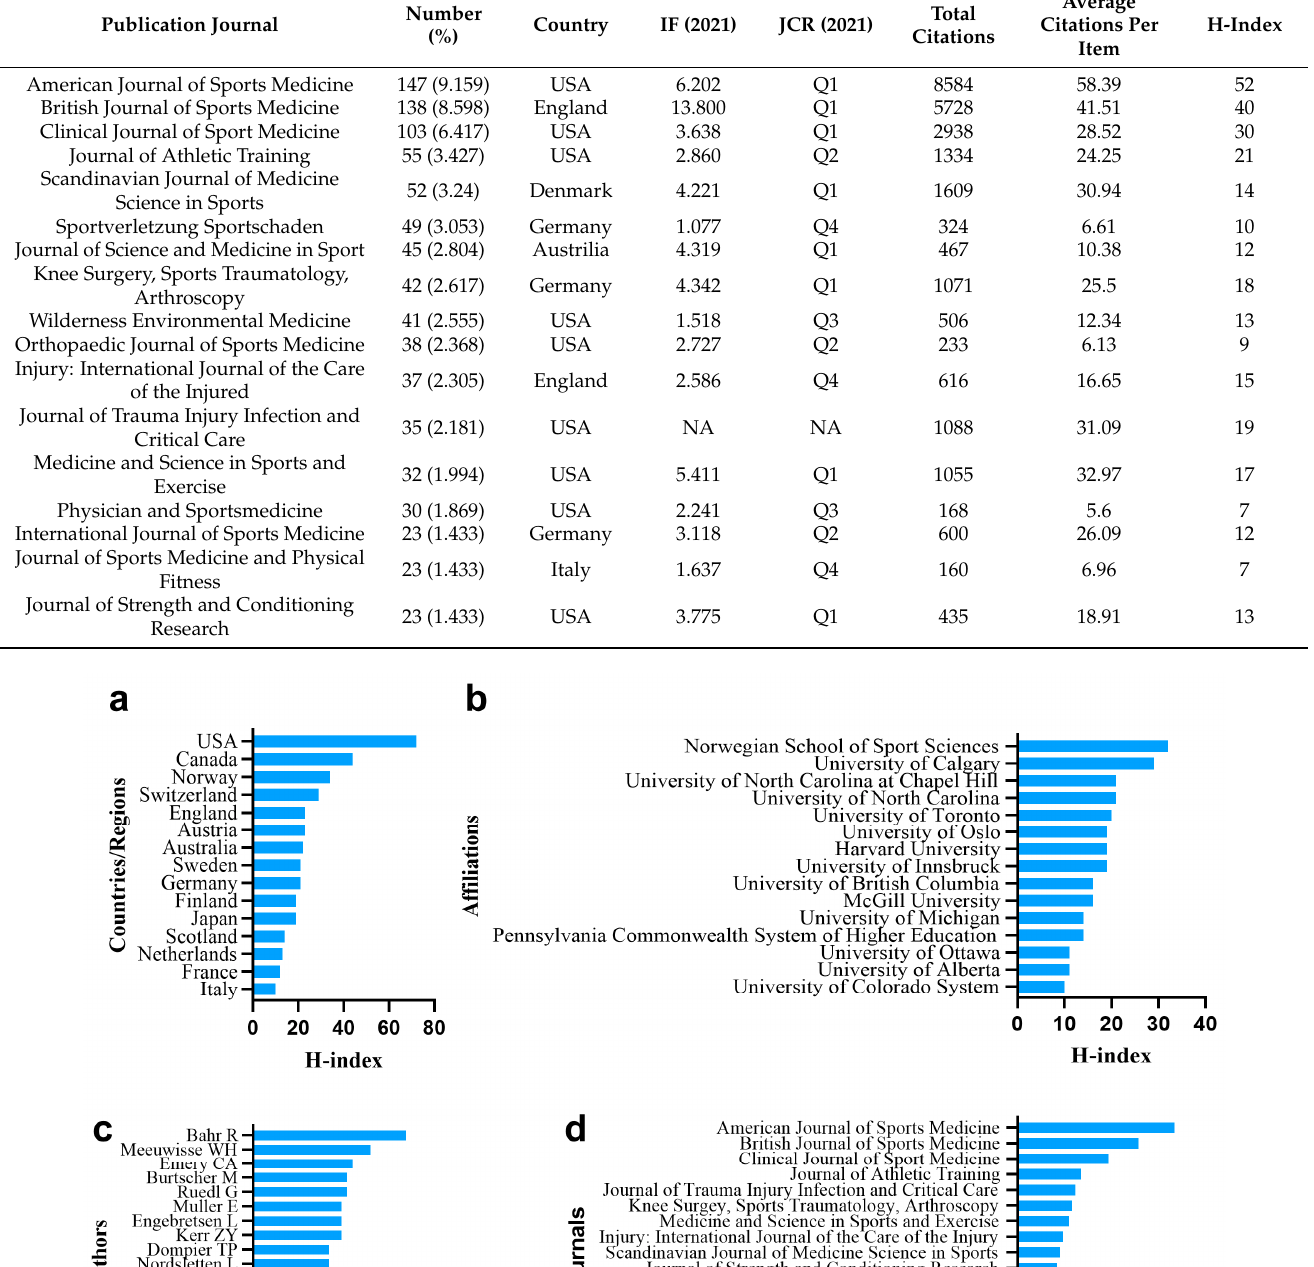
Table 4. The top 15 most published and cited productive journals in the top 3 research directions related to snow and ice sports injuries.